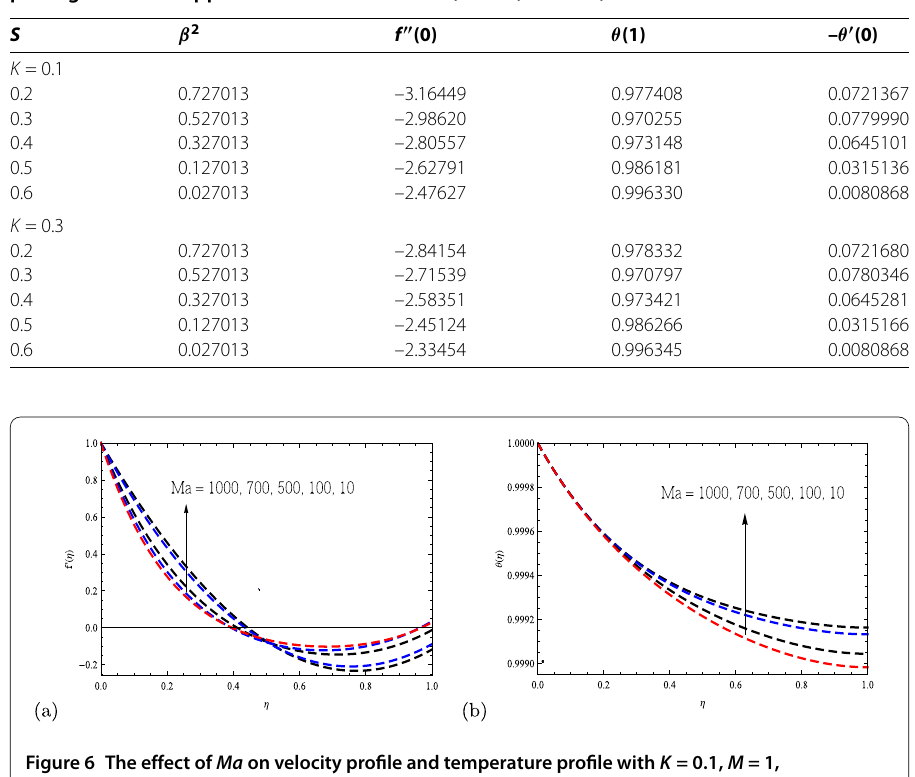
Figure 6 The effect of Ma on velocity profile and temperature profile with K = 0.1, M = 1, ϒ = 0.027013, Pr = 0.2, Gr = 5, S = 0.2.